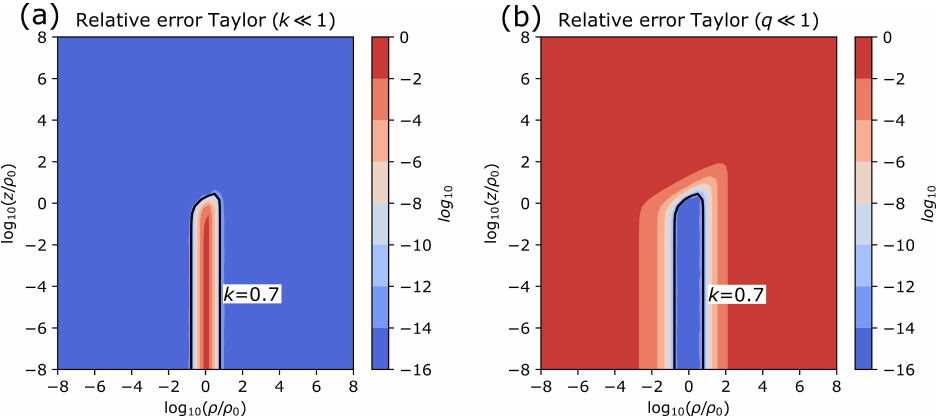
Figure 6. Vectorwise relative error of Taylor approximations of the B -field of a current loop. ( a ) Ex- pansion for small k . ( b ) Expansion for small q